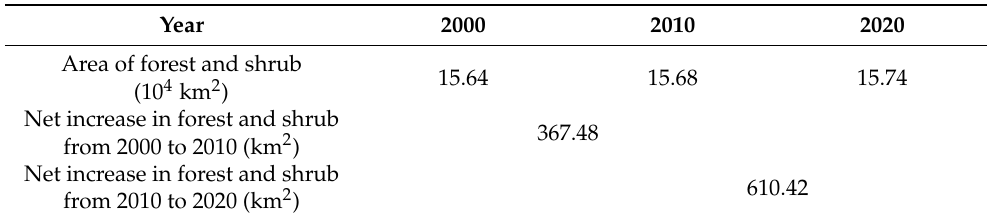
Table 6. Change area of forest and shrub from the year 2000 to 2020.